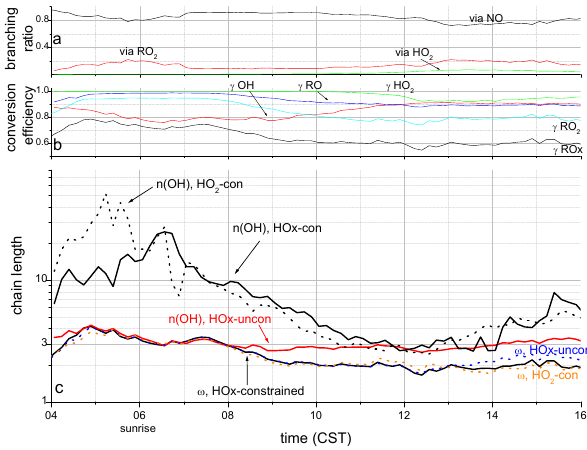
Fig. 6. Panel (a) at the top breaks down the branching ratios of RO 2 → RO radical reaction pathways via NO, RO 2 , and HO 2 to demonstrate that the afternoon chemistry is still very much driven by NO x and much less by organic peroxyl radicals formed as prod- ucts of secondary oxidation. Panel (b) in the middle shows the conversion factors, γ , for the HO x -constrained case. Panel (c) at the bottom shows the chain length parameters, n (OH) for the HOx- constrained (black line, solid), HO x -unconstrained (red line), and HO 2 -constrained (black line, dashed) scenarios and w for the HO x - constrained (black line), HO x -unconstrained (blue, dashed), and HO 2 -constrained (orange, dashed)